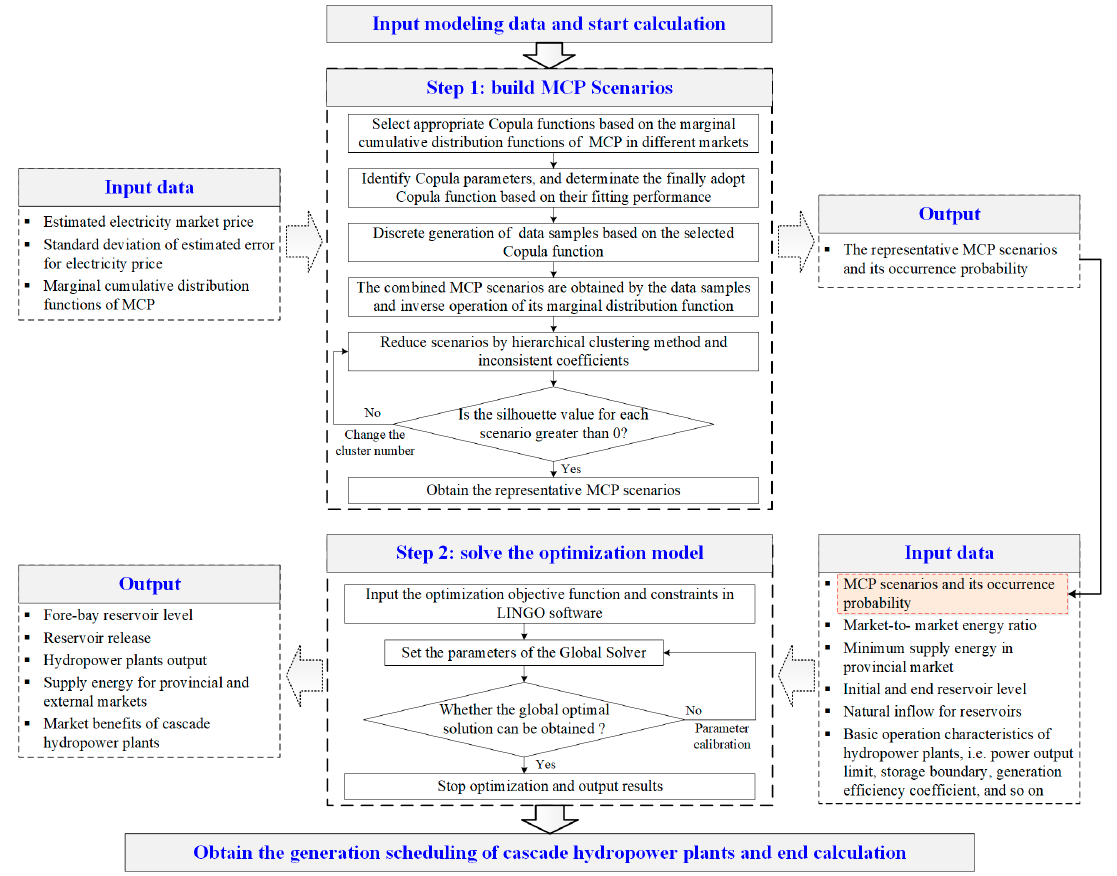
Figure 1. The flow chart for calculation.